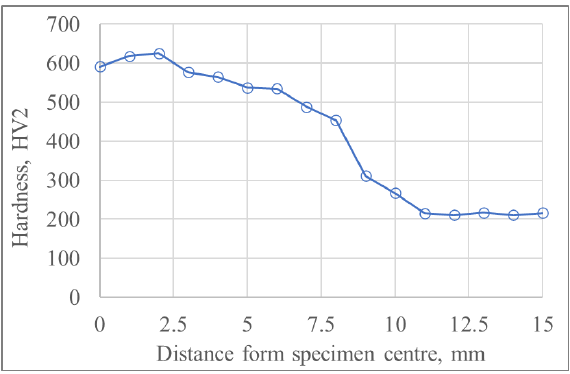
Figure 12. Hardness values along longitudinal direction of USIBOR ® 2000 specimen for the condition of temperature of heated tools equal to 430 °C and quenching time equal to 20 s.